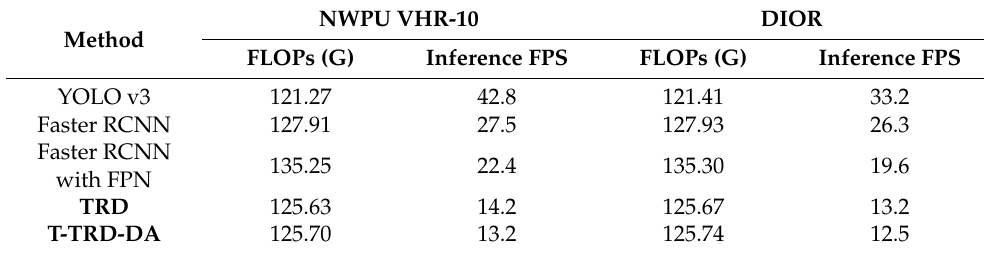
Table 6. Comparison of the computational complexity and inference